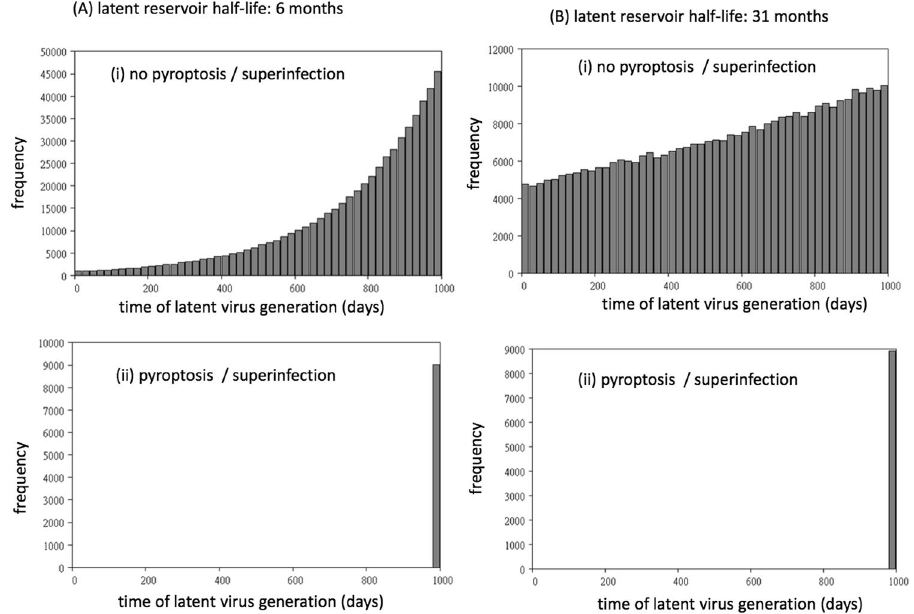
Figure 3. Archiving of viral genomes in the agent-based model assuming a relatively weak immune response against the virus. Computer simulations with and without pyroptosis/superinfection of latently infected cells are compared. The simulation tracks the time when latent genomes are generated during the course of the in silico infection, and the graphs are frequency distributions of the creation times of all latent virus genomes that are present at 1000 days post infection (in the latent reservoir, i.e. in cells that do not contain productive virus). ( A ) It is assumed that the latent reservoir has a half-life of about 6 months 2 . Each time step of the simulation corresponds to 0.1 days, and the probabilities per time step are given as follows. A = 0.045, A 0 = 0.0003, G = 0.0001, B = 0.36, H = 0.01. During infection, Q = 0.95 is the probability of productive infection. The probabilities of CTL proliferation and CTL-induced inhibition of virus replication are determined by parameters C = 0.5, and F = 0.1, respectively. ( B ) Same simulation, assuming that the latent reservoir has a half- life of about 31 months 3 . Parameters were the same, except A 0 = 0.00006, G = 0.000015.